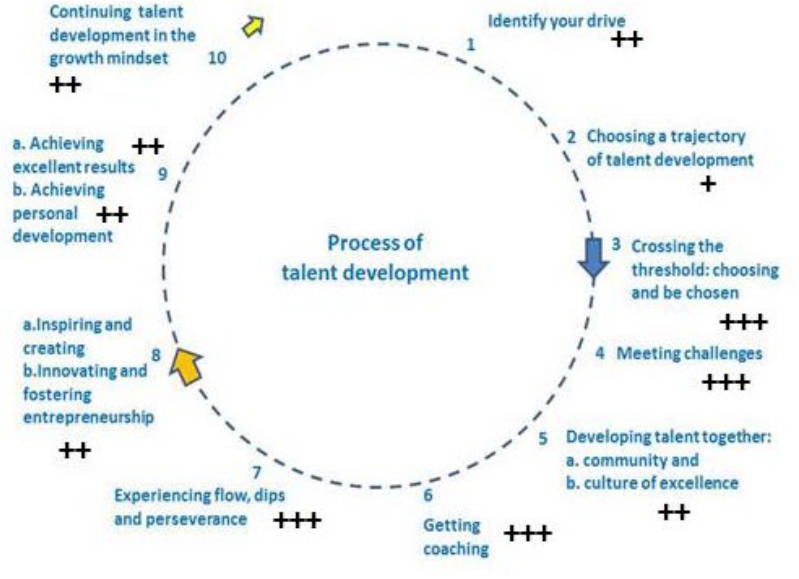
Figure 1. Circle of Talent Development in relation with the good practice ‘Innovation Labs’ with the teacher’s